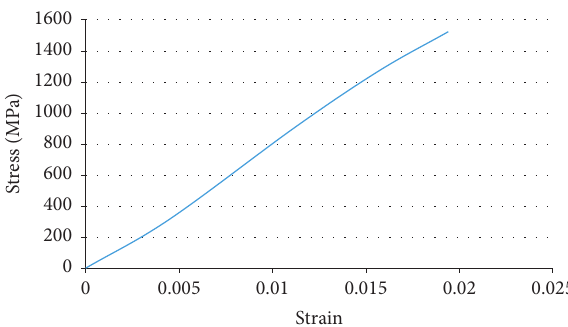
Figure 5: Tensile stress-strain curve of textile